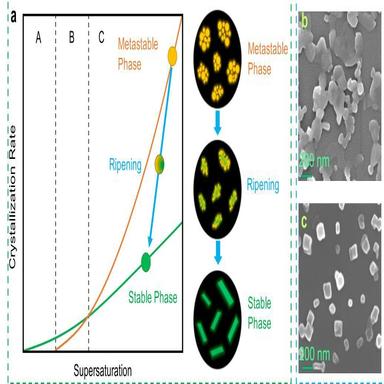
Diagram of the ACPT of ETTDA NPs suspension governed by Ostwald's rule of stages (a). FE-SEM images of amorphous (b) and crystalline (c) for the ETTDA NPs.